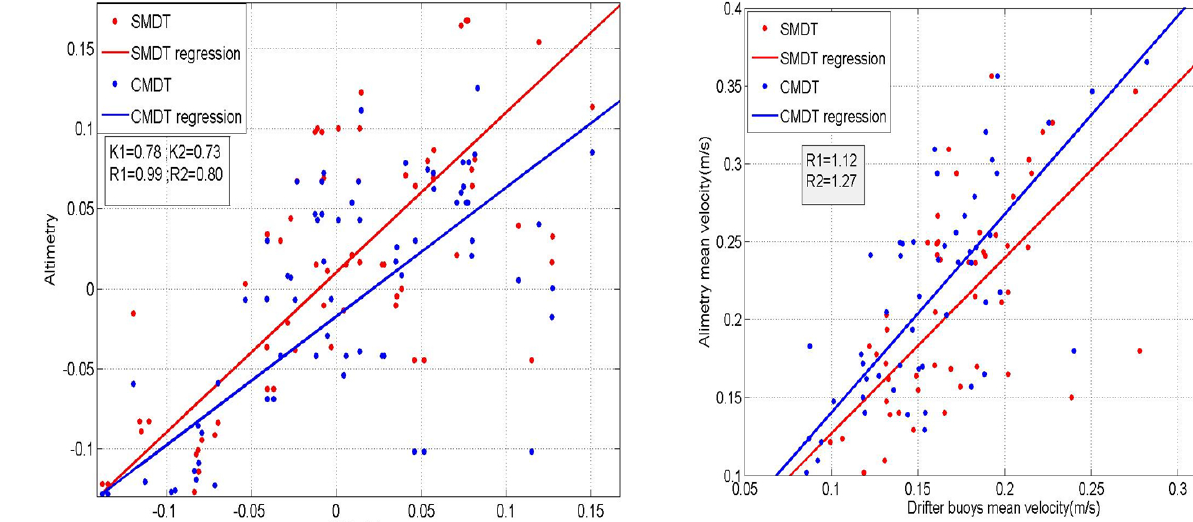
Fig. 8. Scattergram of transformed altimetric dynamic heights h 1 ,h 2 , reconstructed with use of SMDT and CMDT, respectively, and in-situ dynamic heights h is .